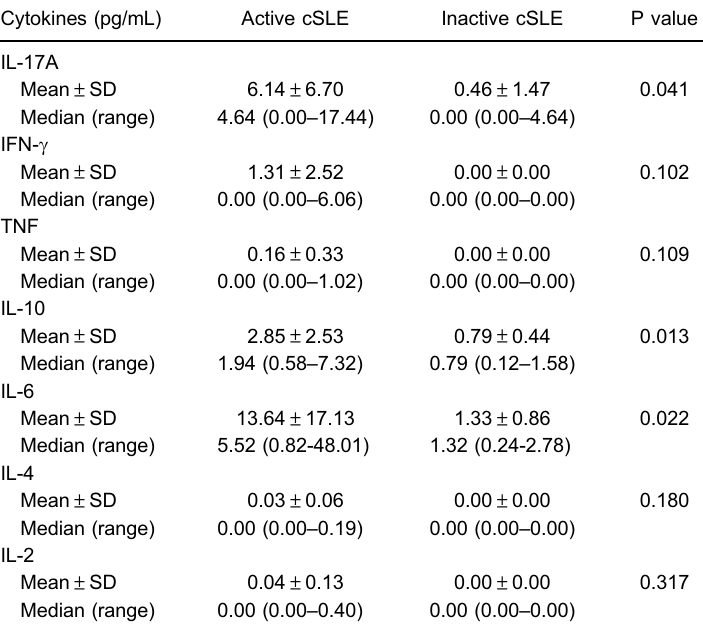
Table 3. Longitudinal follow-up study of 10 childhood-onset systemic lupus erythematosus (cSLE) patients at two distinct moments: active disease and inactive